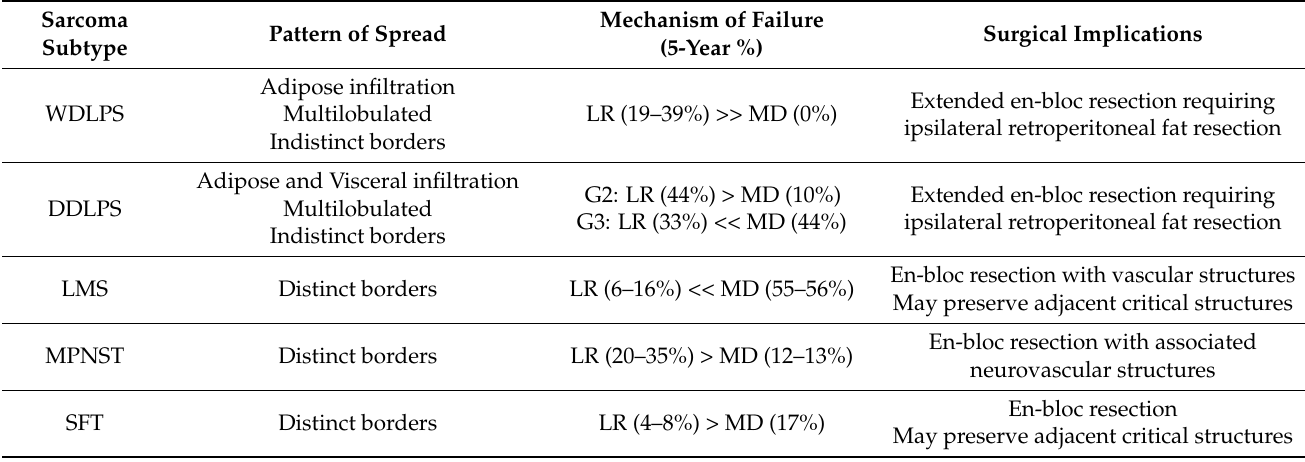
Table 3. Retroperitoneal sarcoma subtypes with associated patten of spread, mechanisms of local and distant failure with associated 5-year local recurrence and 5-year metastatic disease, and surgical